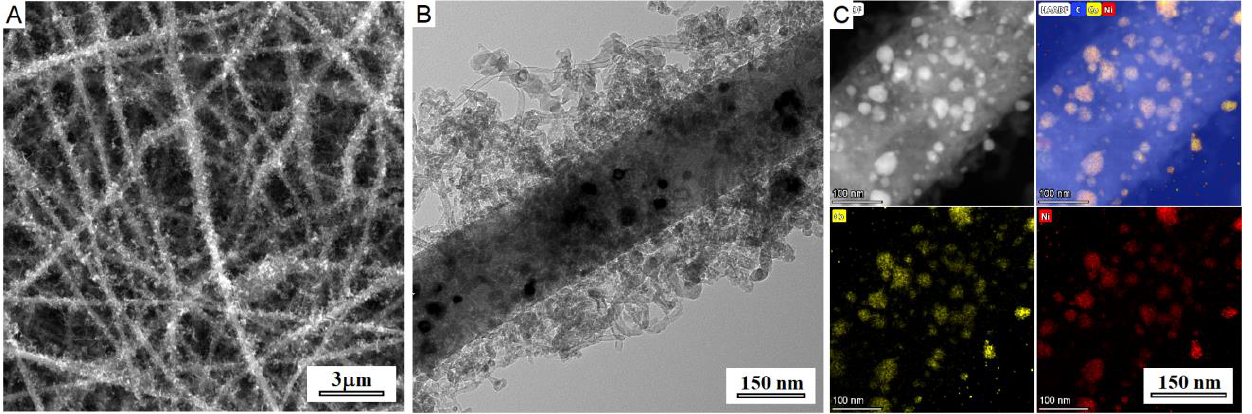
Figure 1. ( A ) SEM and ( B ) TEM images of eCNF/CNT/NiCo nanocomposite. ( C ) HAADF-STEM/EDX mapping showing elemental distribution in the NiCo nanoparticles.